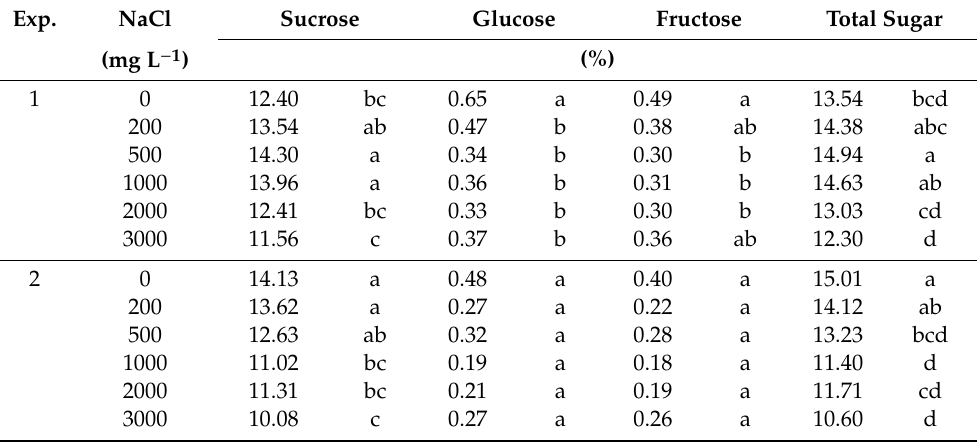
Table 3. E ff ects of NaCl levels in irrigation water on juice sugar composition.